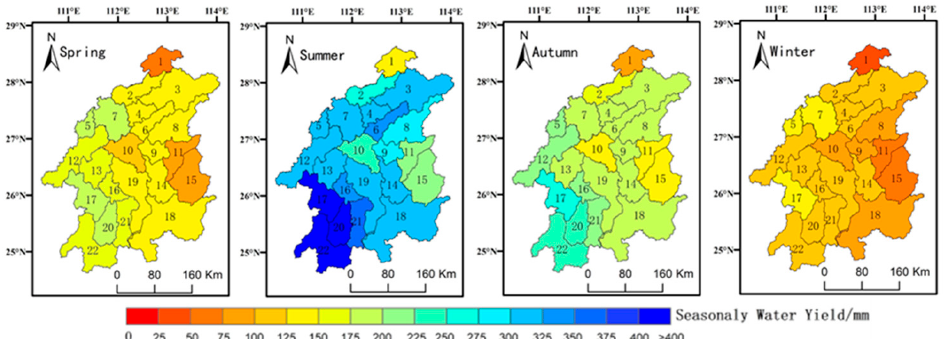
Figure 6. Spatial variation in seasonal average water yield.